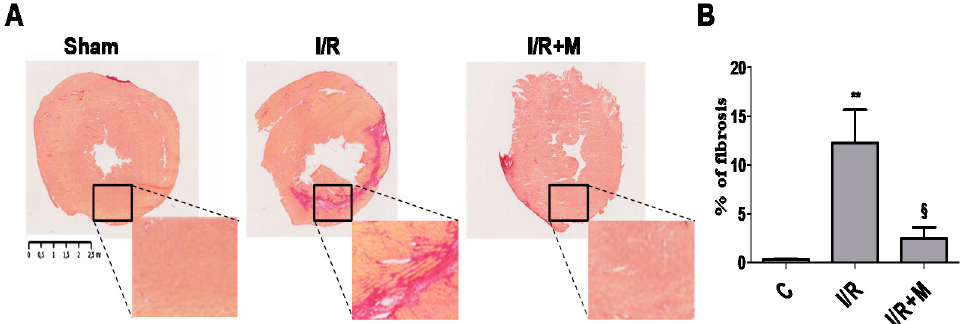
Figure 1. Metformin treatment prevents fibrotic remodeling in postinfarcted myocardium. ( A ) Representative images of wheat germ agglutinin (WGA) staining of frozen heart tissue sections; scale bar is 25 µm. Frozen sections from vehicle- or metformin-treated mice subjected to 30 min of car- diac ischemia and 14 days of reperfusion were stained with WGA. Metformin treatment (5 mg/kg, i.p.) started 15 min after the onset of reperfusion and continued for 14 days. ( B ) Quantification of fibrotic area from ( A ), n = 3–5. Data are presented as mean ± SEM. One-way ANOVA followed by Bonferroni’s post hoc test: *** p < 0.001 vs. control (C), §§§ p < 0.001 vs. I/R.